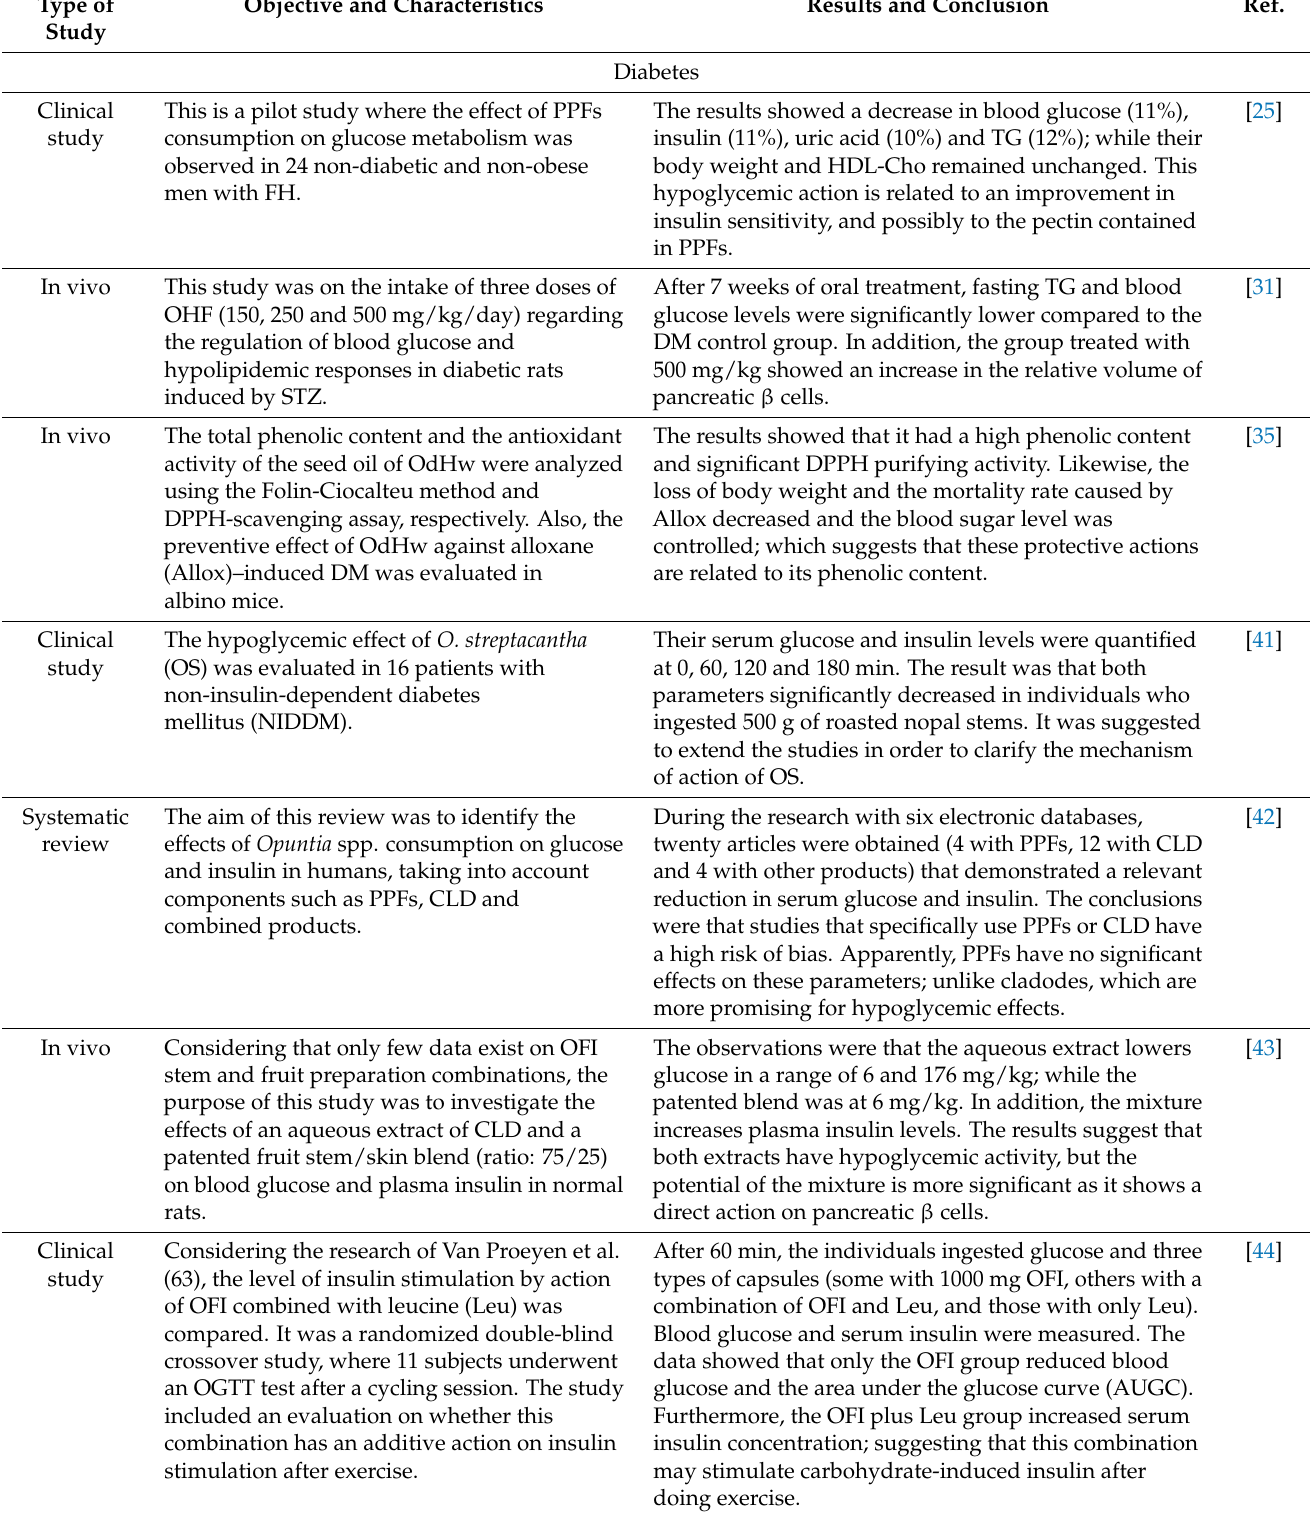
Table 3. Main studies of Opuntia spp. on its effects in diabetes and